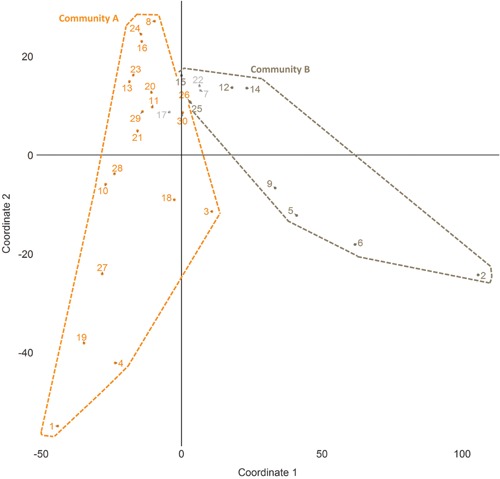
Non-metric multidimensional scaling (nMDS) plot of individual space usage. Scaling plot of the first two coordinates generated from nMDS analysis of the number of agonistic interactions undertaken by each subject in each vivarium. Numbers refer to I&SI ranks.